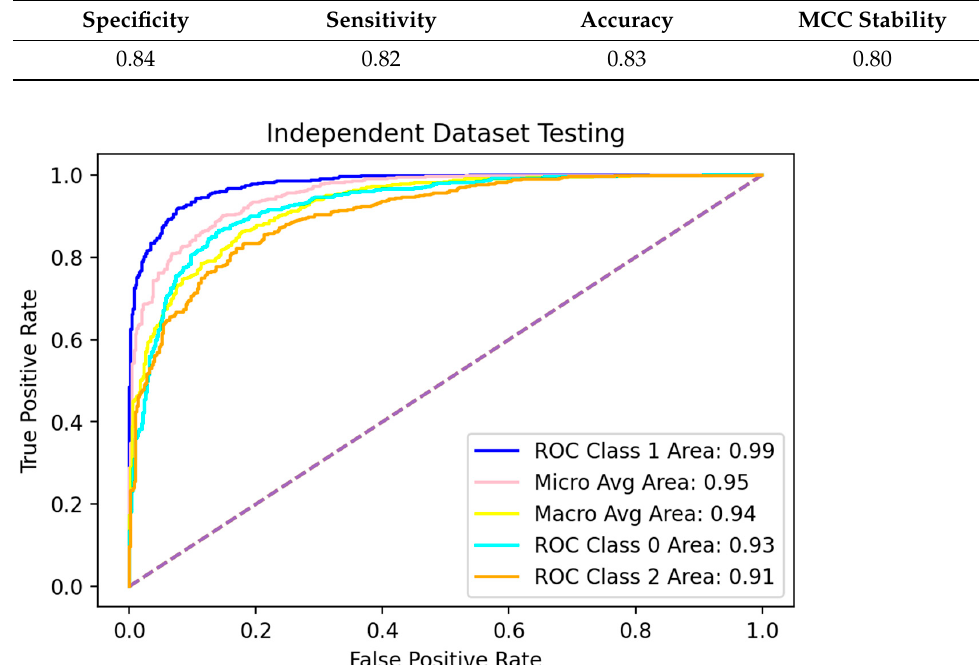
Table 7. Comparison of accuracy score for the proposed model with other ML algorithms.